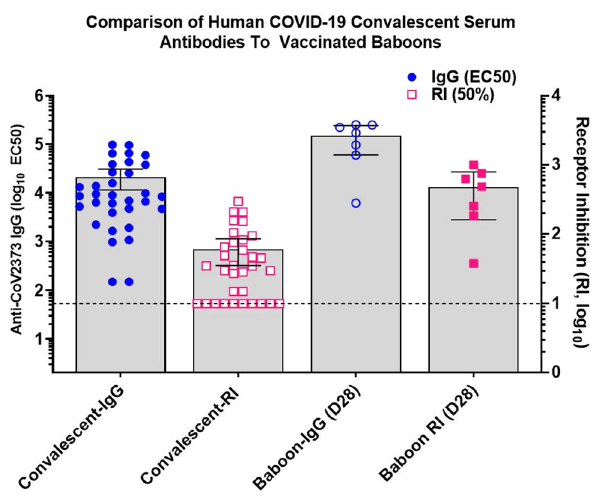
Fig. 9 Comparison of COVID-19 human convalescent serum antibody levels to NVX-CoV2373-vaccinated baboon antibody levels.